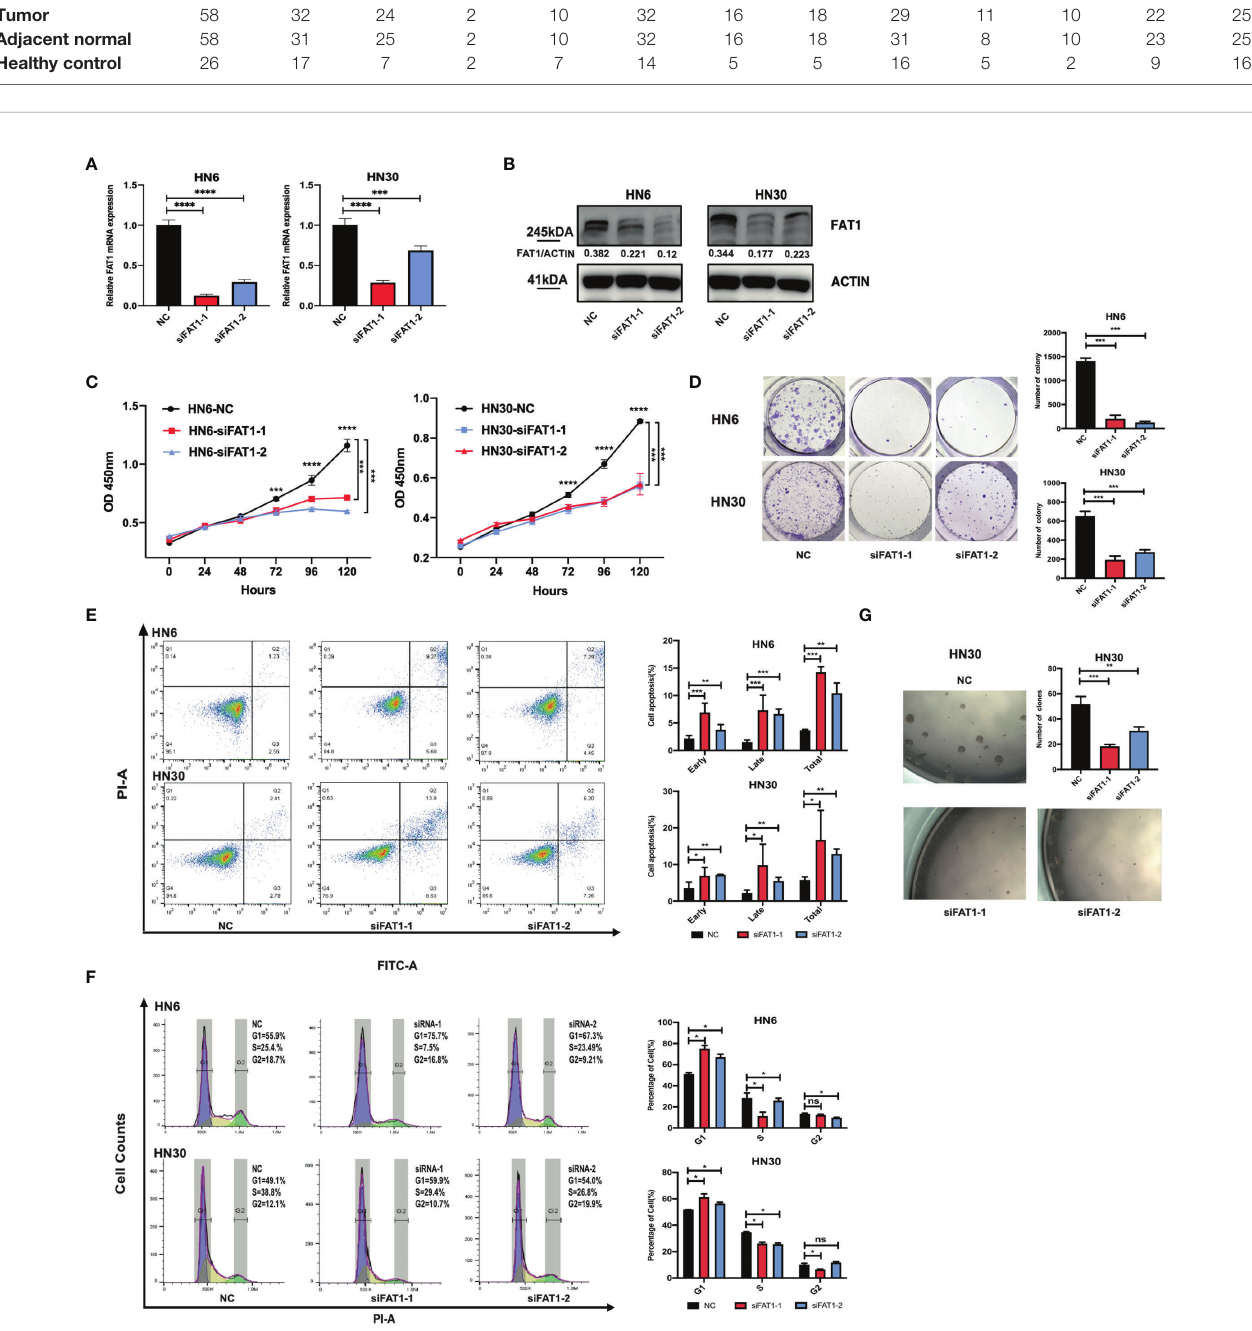
FIGURE 4 | Downregulation of FAT1 impairs OSCC proliferation, cell cycle, and stemness, and promoted cell apoptosis. FAT1 knockdown by siFAT1-1 and siFAT1-2 in both HN6 and HN30 was con fi rmed by qPCR (A) and Western blot (B) . FAT1 knockdown by siFAT1-1 and siFAT1-2 inhibited HN6 and HN30 cell proliferation via CCK8 analysis (C) and clone formation (D) , facilitated cell both early and late apoptosis (E) , promoted cell cycle arrest (F) , and suppressed the tumorsphere formation of HN30 (G) . *P < 0.05; **P < 0.01; ***P < 0.001; ****P < 0.0001; ns, not signi fi cant.